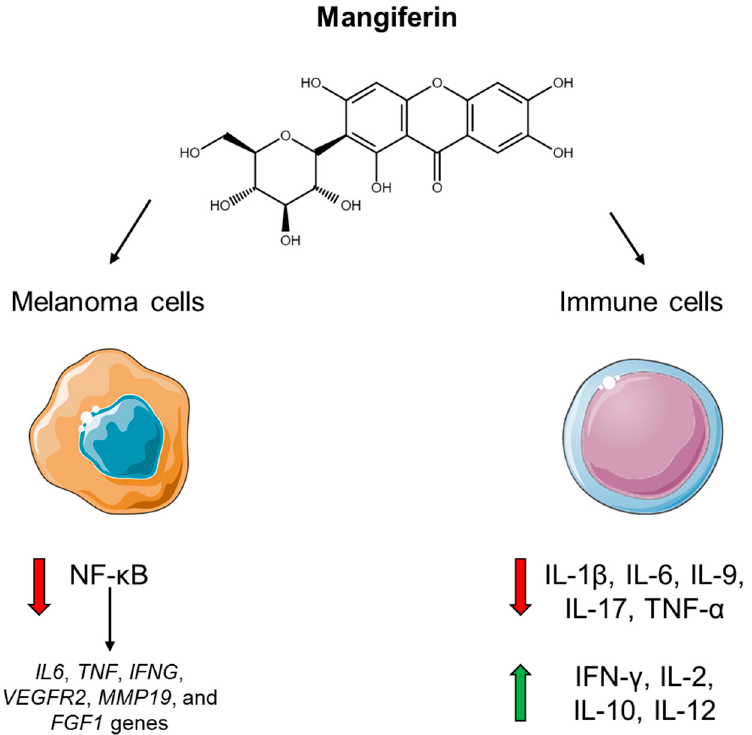
Figure 9. Mechanisms of action on melanoma and immune cells. Parts of the figure are drawn using pictures from Servier Medical Art (https://smart.servier.com, (accessed on 20 January 2023)). Shikonin is a naphthoquinone from the root of Lithospermum erythrorhizon Sieb. et Zucc. (Boraginaceae), and exhibited anti-angiogenic properties in a B16 melanoma model [244]. In addition, shikonin induces high expression level of RANTES, and shows promising immune-modulatory activity as an adjuvant in a human gp100-transfected B16 mouse tumor model [245].